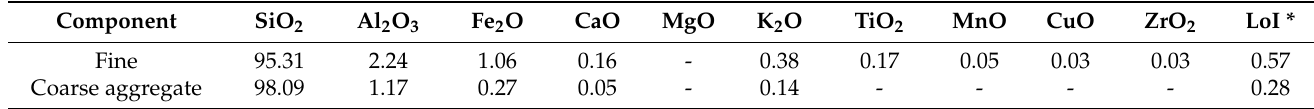
(XRF) is given in Table 1, which attests to their high siliceous content. Table 1. Chemical composition of natural fine and coarse aggregate . Table 1. Chemical composition of natural fine and coarse aggregate.